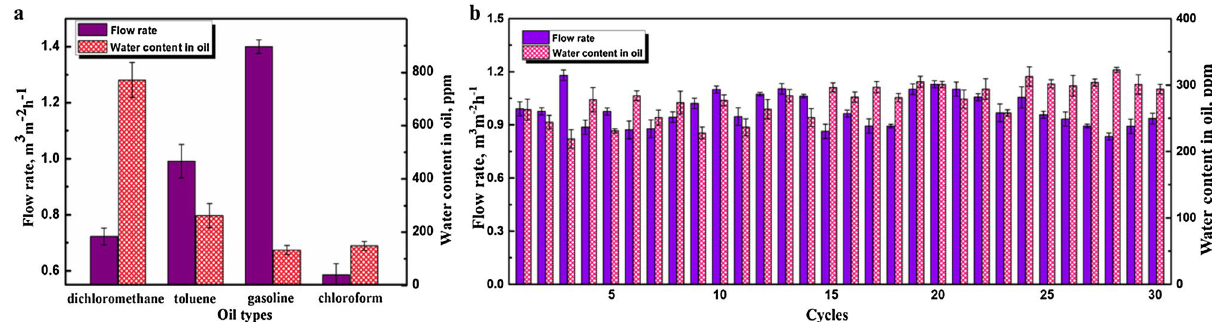
Figure 5. Oil–water separation application. ( a ) Separation efficiencies and flow rates with different oil–water mixtures. ( b ) Cycle stability of the separation